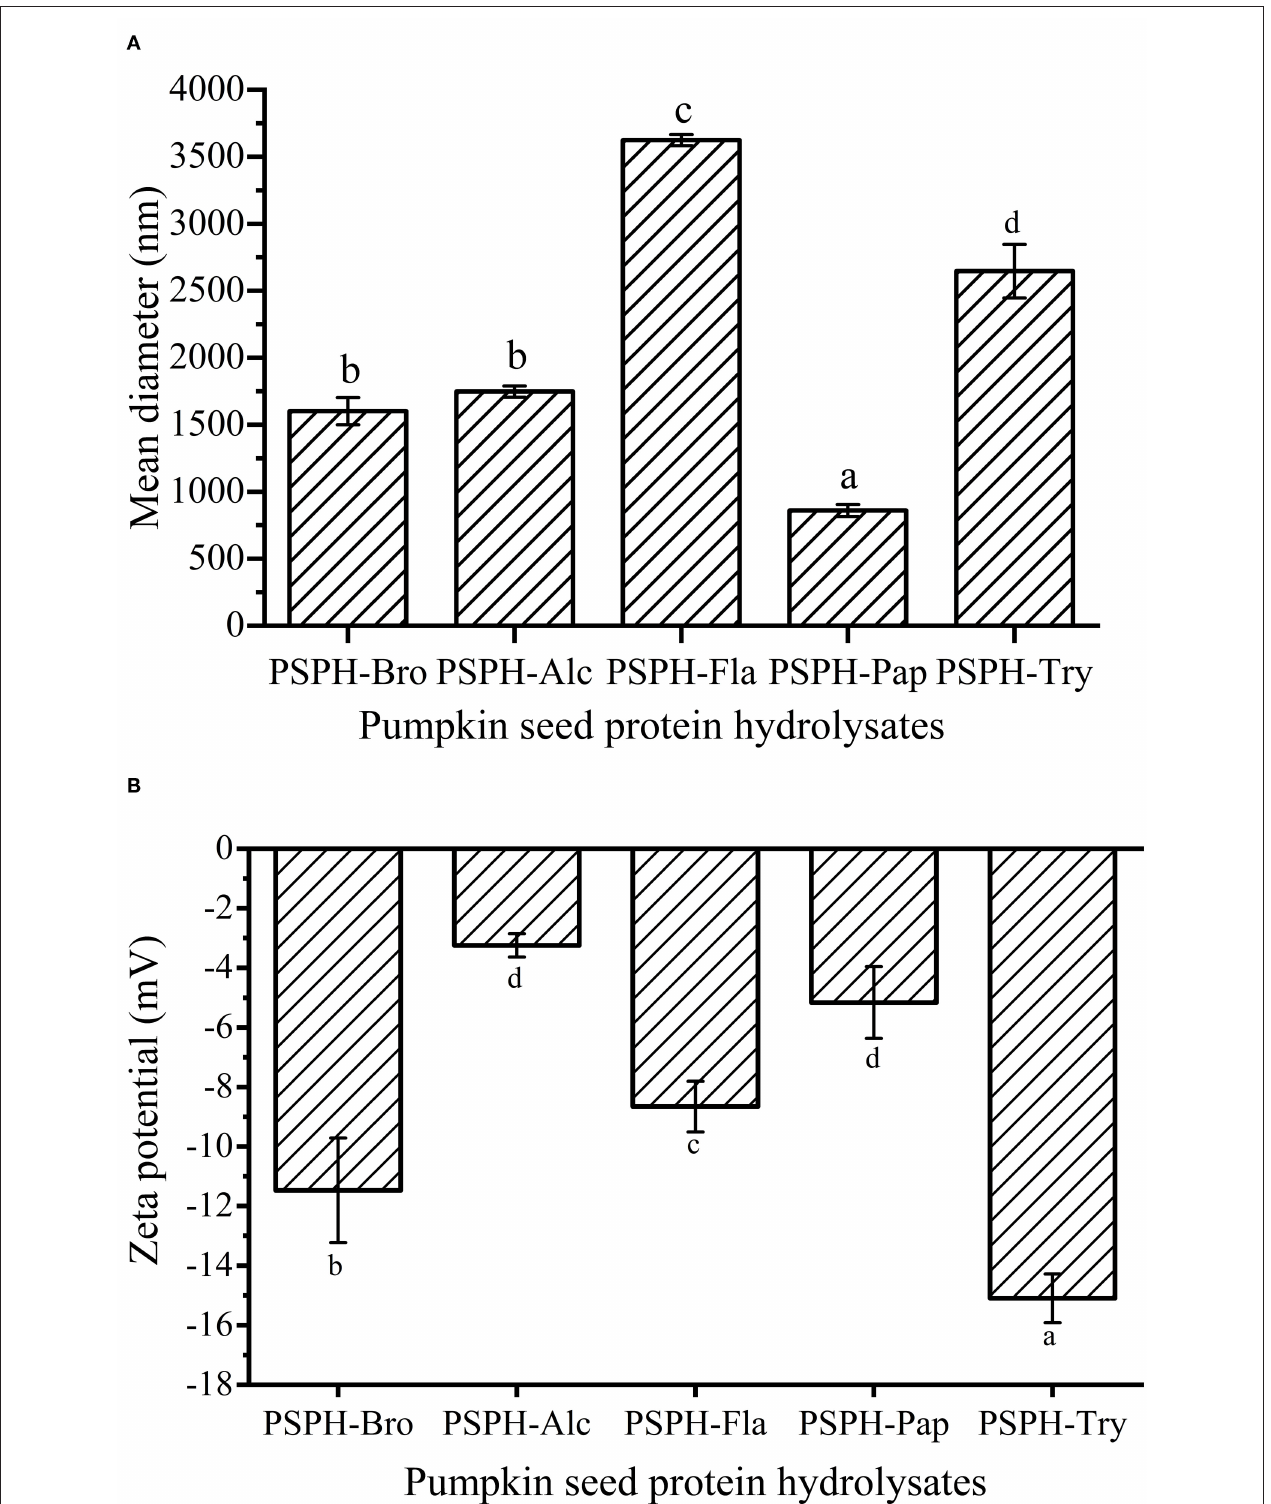
FIGURE 3 | Mean particle diameter (A) and Zeta potential (B) of pumpkin seed protein produced with bromelain (PSPH-Bro), alcalase (PSPH-Alc), flavourzyme (PSPH-Fla), papain (PSPH-Pap), trypsin (PSPH-Try) after hydrolysis 3h in a 2% (w/w) enzyme to substrate ratio. Bars in each chart with different letters represent significantly different mean values with P < 0.05. Different letters represent significantly different mean values with P < 0.05.